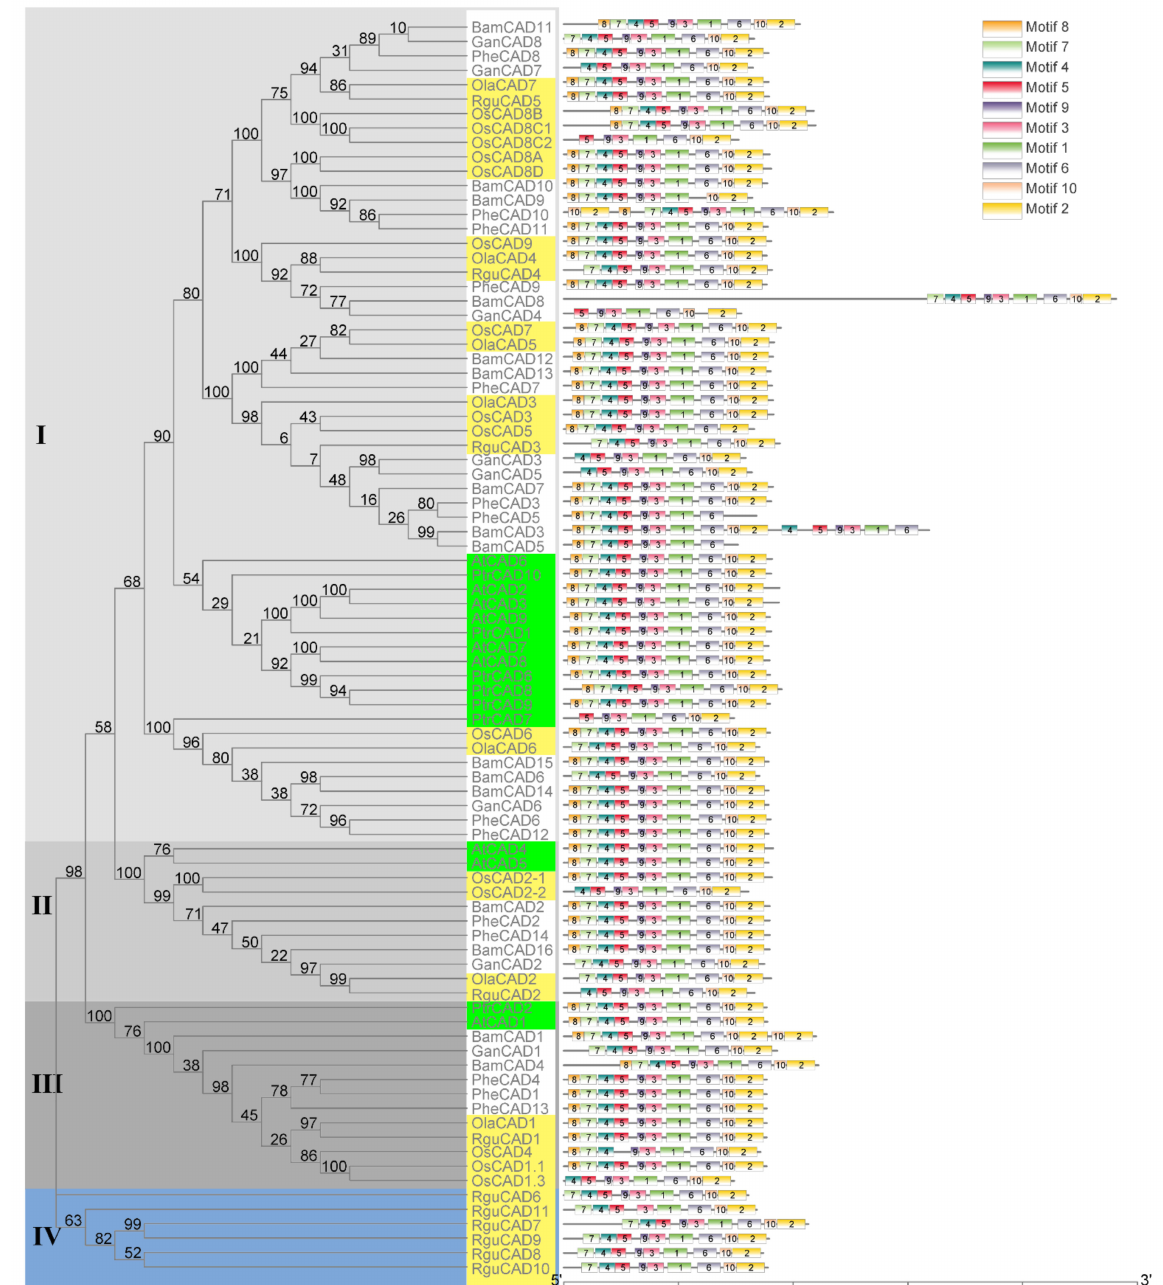
Figure 1. The phylogenetic relationship among CAD genes of Bambusoideae. The phylogenetic tree was constructed using CAD protein sequences of P. trichocarpa (Ptr), Arabidopsis thaliana (At), Oryza sativa (Os), O. latifolia (Ola), P. edulis (Phe), G. angustifolia (Gan), R. guianensis (Rgu) and B. amplexicaulis (Bam). Clade I, II and III are indicated in different ash shades and Clade IV in blue. The dicot plant CAD genes were indicated in the green boxes and the diploid rice and bamboo species are shown in light yellow boxes. The conserved motifs (1–10) are indicated in ten different colour